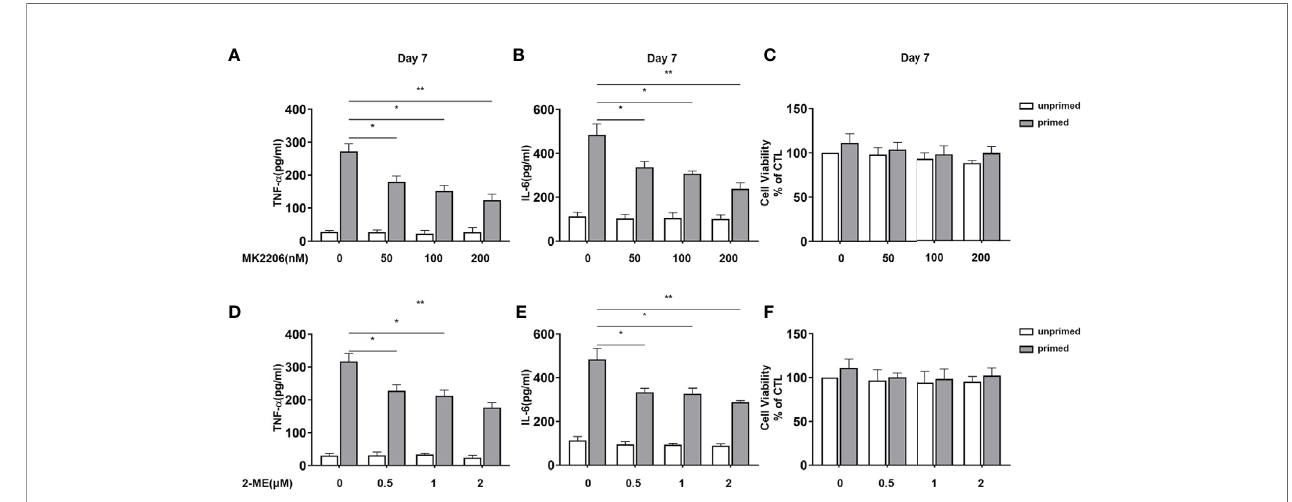
FIGURE 8 | Inhibition of Akt or HIF-1 a suppressed BAFF training of BV2 cells in a dose-dependent manner. (A – C) BV2 cells were pretreated with different doses of MK2206, a speci fi c Akt inhibitor (50, 100, 200 nM) for 3 h, and then primed with BAFF for 24 h. After a rested of 5 days, cells were restimulated with BAFF for 24 h. The amounts of TNF- a (A) and IL-6 (B) were measured in the culture supernatants and the cytotoxicity of MK2206 was measured by MTT (C) on day 7(n = 12). (D- F) BV2 cells were pretreated with different doses of 2-Methoxyestradiol (2-ME), a speci fi c HIF-1 a inhibitor (0.5, 1, 2 m M) for 3 h, and then primed with BAFF for 24 h. The secretion of TNF- a (D) and IL-6 (E) and the cytotoxicity of 2-ME (F) were measured on day 7 upon BAFF restimulation (n = 12). The data are mean ± SEM; Kruskal-Wallis test with Turkey post hoc test; *p < 0.05, **p < 0.01.